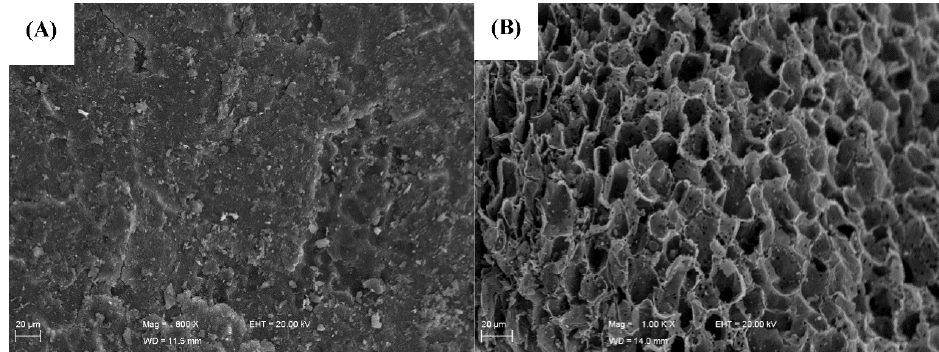
Figure 2. SEM micrographs (×800 and ×1000) of ( A ) an in natura pecan shell (PS); and ( B ) the bio- sorbent (PSB).